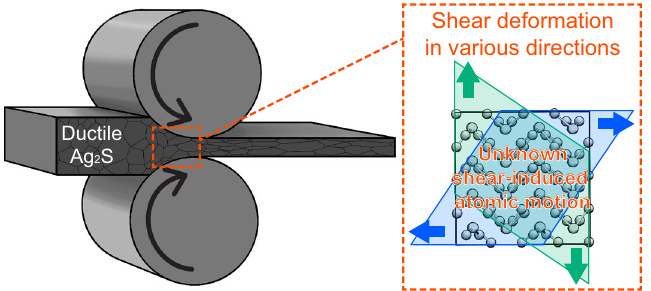
Figure 1. Schematic illustration of research objective. Rolling process of ductile semiconducting Ag 2 S (left) and a shear strained single-crystalline domain (right).